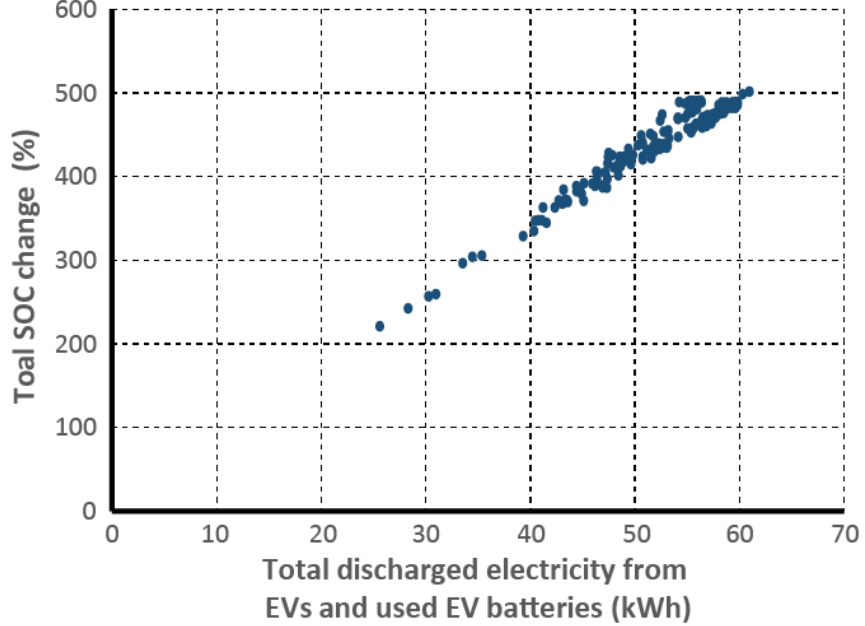
Figure 12. Correlation of total SOC change to the total discharge electricity from both EVs and used EV